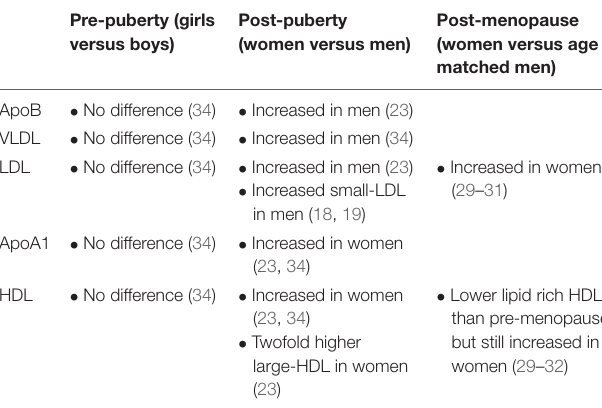
TABLE 1 | Sex differences in lipoproteins across pubertal